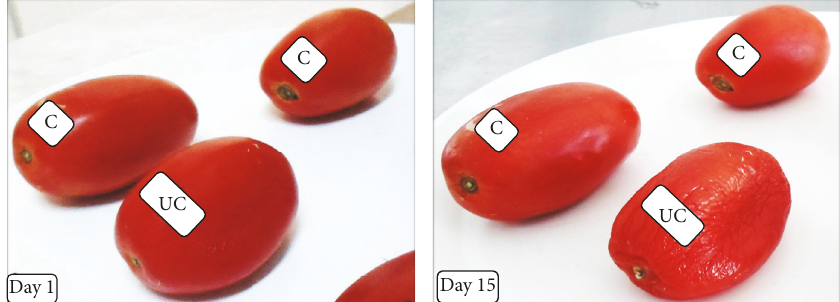
Figure 1: Effect of storage period (day 1 and day 15) on Roma tomatoes coated with guar gum (C) and uncoated (UC), under ambient temperature conditions ( 22 ± 2 ∘ C).